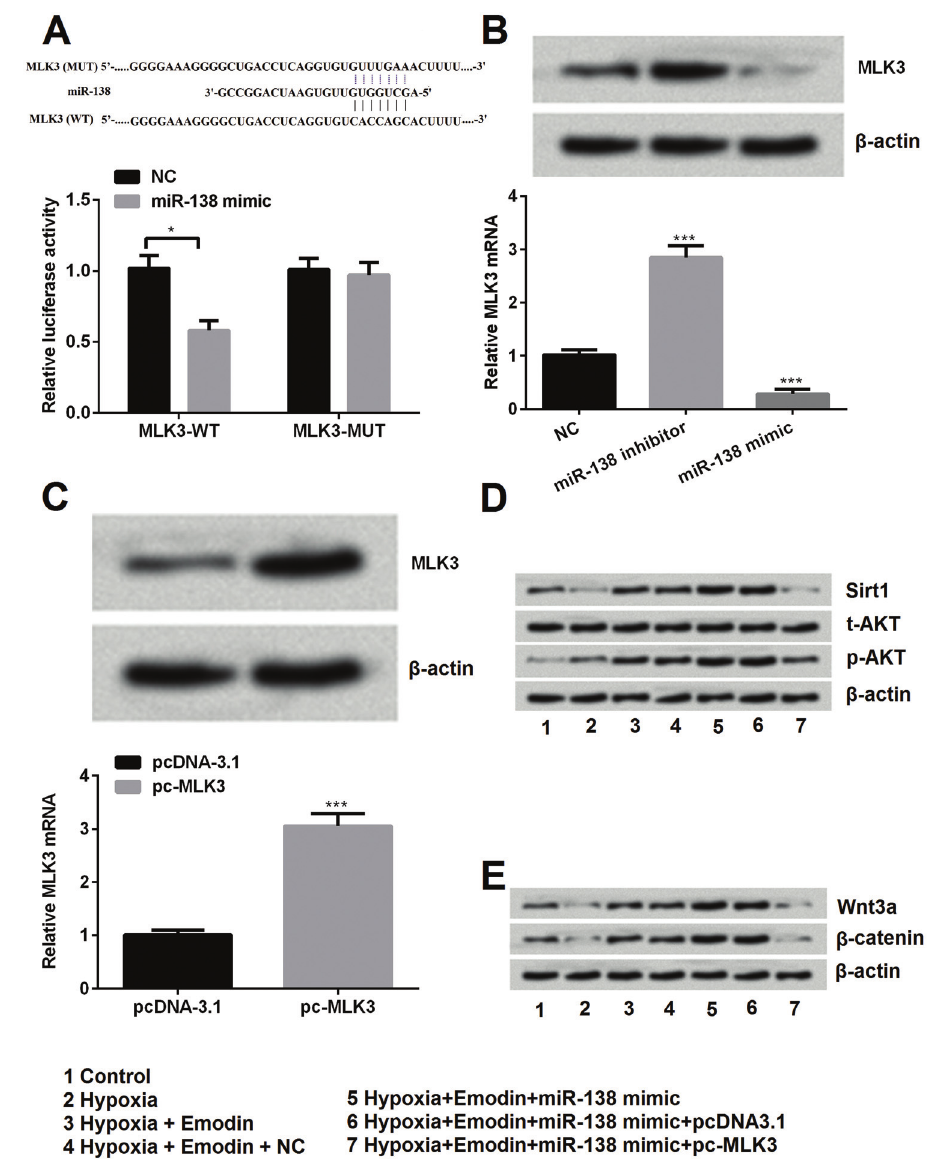
Figure 7. Emodin alleviated hypoxia-induced cell injury via downregulation of MLK3. A , Dual luciferase activity assay was performed to con fi rm miR-138 target MLK3. B , miR-138 negatively regulated expression of MLK3. C , Overexpression of MLK3 was accessed by transfection with pc-MLK3. Under emodin treatment, ( D ) Sirt1/AKT pathway and ( E ) Wnt/ b -catenin pathway were inactivated by co- transfection with miR-138 mimic and pc-MLK3 compared with negative control (NC). The expression of protein was measured by western blot. Data are reported as means ± SD of triplicates. Each experiment was performed three times. *P o 0.05, ***P o 0.001, Student ’ s t -test and one-way analysis of